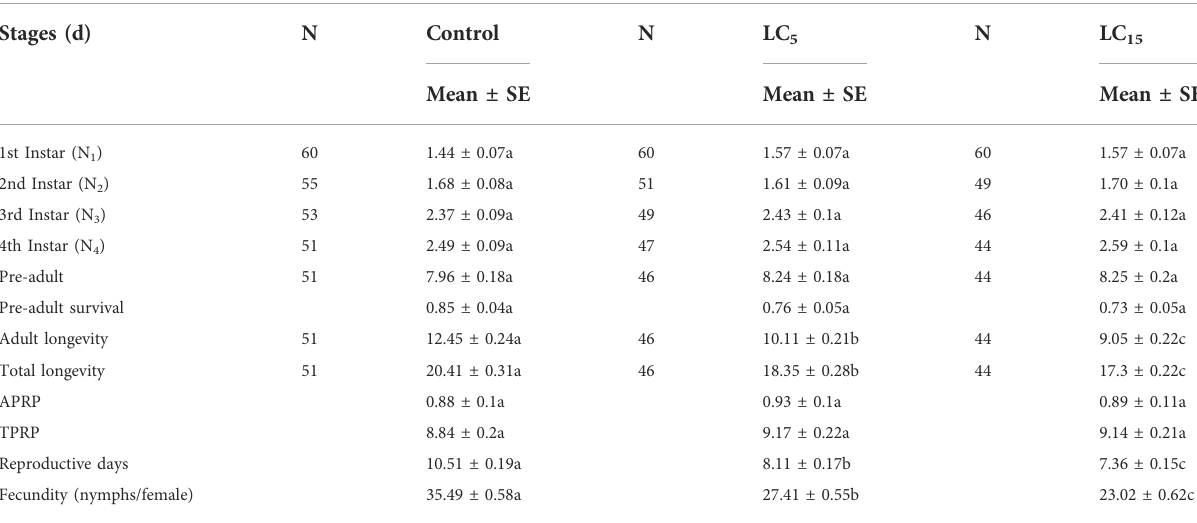
TABLE3Developmentalduration,longevityandfecundityofdifferentstagesforF 1 generation B.brassicae afterexposureofparentaladult(F 0 )tothe LC 5 and LC 15 of